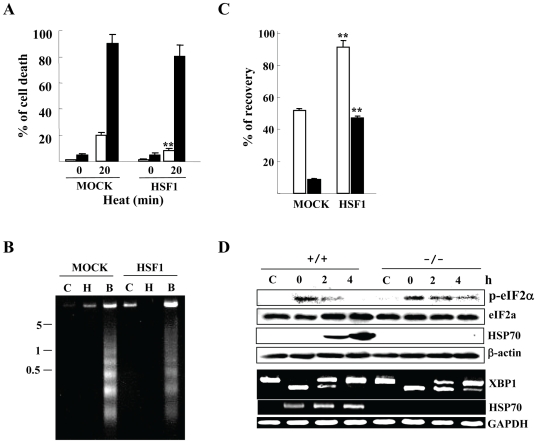
HSF1 rescue into HSF -/- MEFs.
A) Cell death at 24 h after heat exposure (42.5°c) for 20 min with (closed) or without (open bars) 0.5 mM H2O2 pretreatment. **, P<0.01 compared with MOCK transfectants. B) DNA fragmentation. Small molecular DNAs were prepared from cells (C: control, H: 42.5°c for 10 min, B: heat and 0.5 mM H2O2) 24 h after heat exposure. Numbers indicate molecular weights (kilo bases). C) Effect of H2O2 pretreatment on refolding activity. Cells were transiently co-transfected with the wild-type pHSF1 expression vector (HSF1) or its vehicle (MOCK) with the pGRE/RL-TK reporter genes, treated with 5 mM dexamethazone for 10-12 h, treated by thermal preconditioning as described in Fig. 6D
, exposed to heat (42.5°c for 20 min) with (closed) or without (open bars) 0.5 mM H2O2 pretreatment, incubated for 5 h and luciferase activity was measured. **, P<0.01 compared with MOCK transfectants. D) eIF2α phosphorylation and XBP1 splicing. After exposure to heat (43.5°c for 20 min), HSF +/+ and -/- MEFs were harvested at the indicated hours. The eIF2α phosphorylation and HSP70 expression were evaluated by western blots using the indicated antibodies. Anti-β-actin antibody shows equal loading of protein samples. XBP1 splicing and HSP70 mRNA expression were evaluated by RT-PCR. GAPDH mRNA levels ensure that the RNA was correctly quantified. In A and C, error bars indicate the mean ± S.D. of data from three separate experiments.